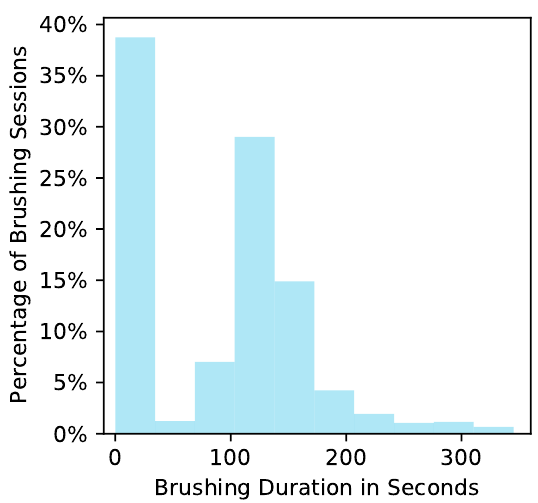
Figure 2. Histogram of brushing durations in seconds for all user brushing sessions in ROBAS 2. The ROBAS 2 study had 32 users total and each user had 56 brushing windows (2 brushing windows per day for 28 days). If a user did not brush during a brushing window, their brushing duration is recorded as zero seconds. Note in the figure above that across all users and brushing windows, about 40% of brushing sessions had no brushing, that is, a brushing duration of zero seconds. The ROBAS 2 brushing durations are highly